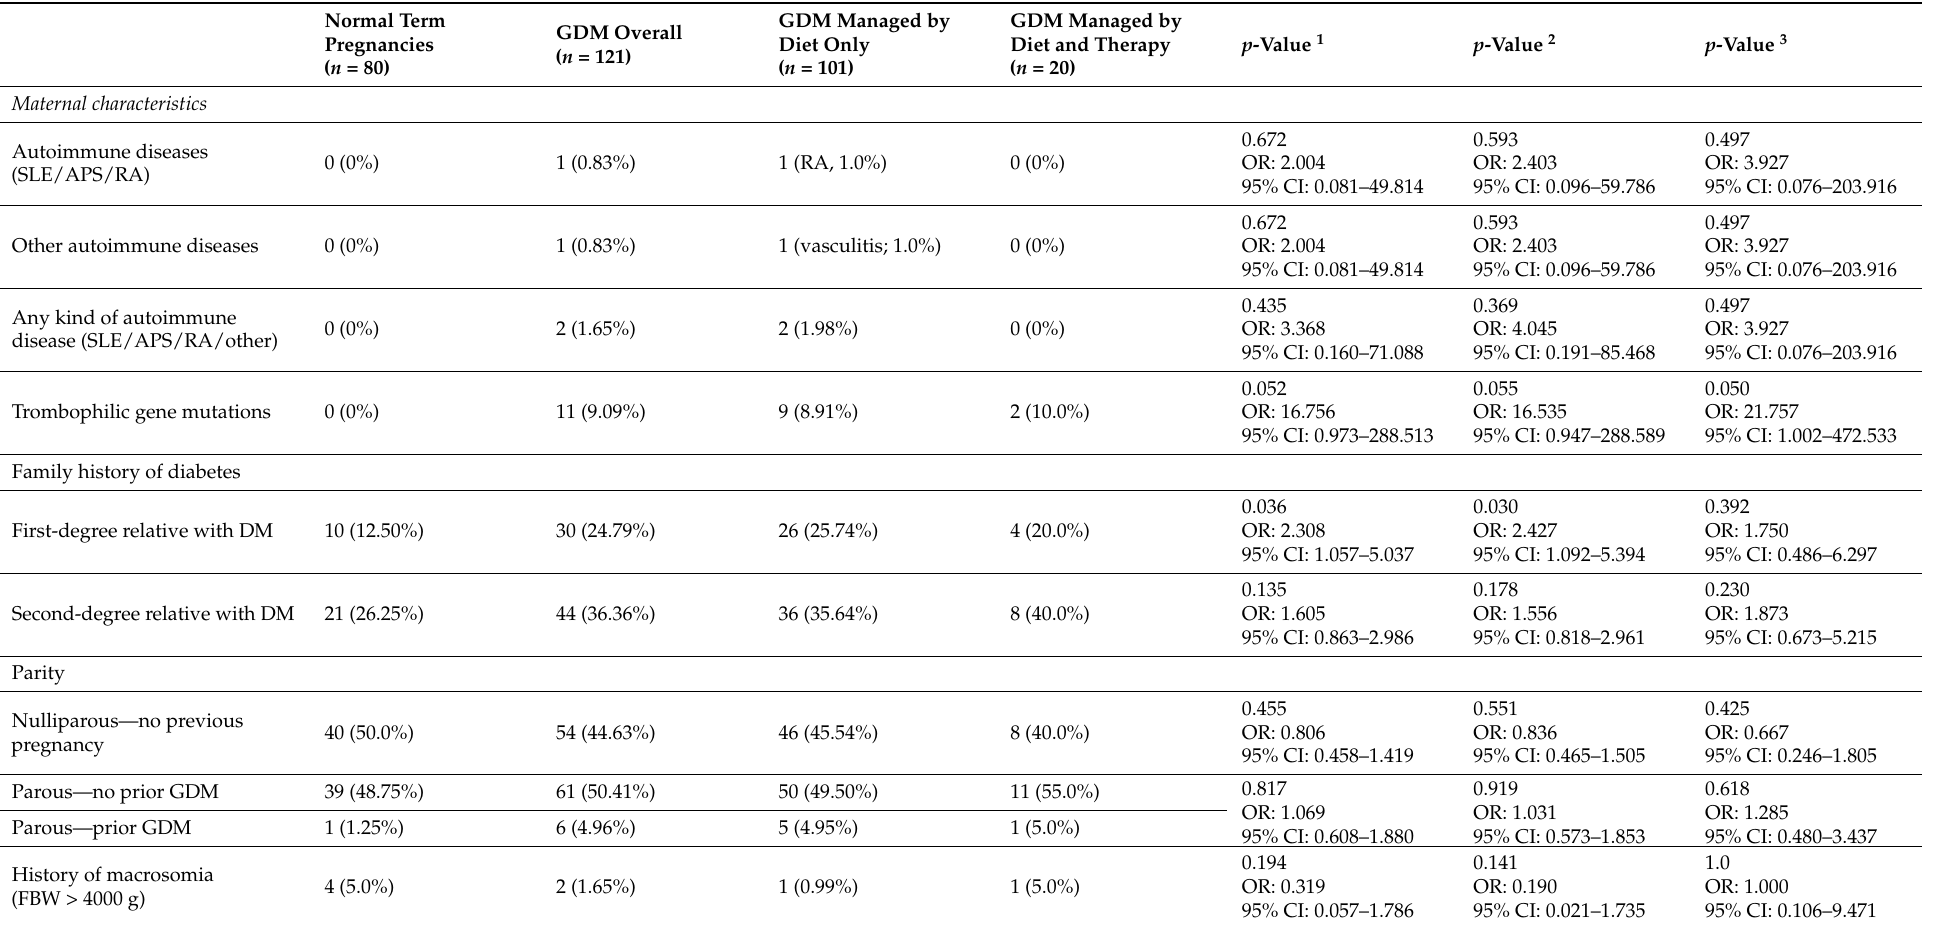
Table 2. Clinical characteristics of the cases and